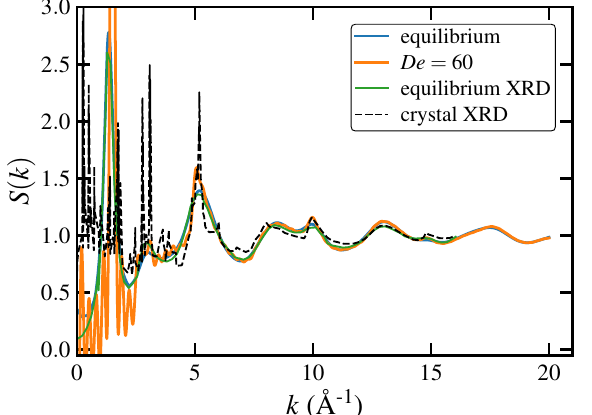
Figure 16. Panel ( a ): A snapshot of a random slab of thickness 11.8 Å and oriented perpendicular to the direction of flow of the semicrystalline PE taken under steady-state UEF at De = 60.0. Individual molecules are assigned random colors, and each atom contained within the slab of a particular molecule is assigned the same color. Most molecules are aligned parallel to the flow direction and hence appear as large dots in the plane of the slab. Panel ( b ): A graph of g ( r ) for a random slab of thickness 3 Å oriented perpendicular to the flow direction, similar (but thinner than) the slab of Panel ( a ). The monoclinic lattice parameters are labelled in the plot.